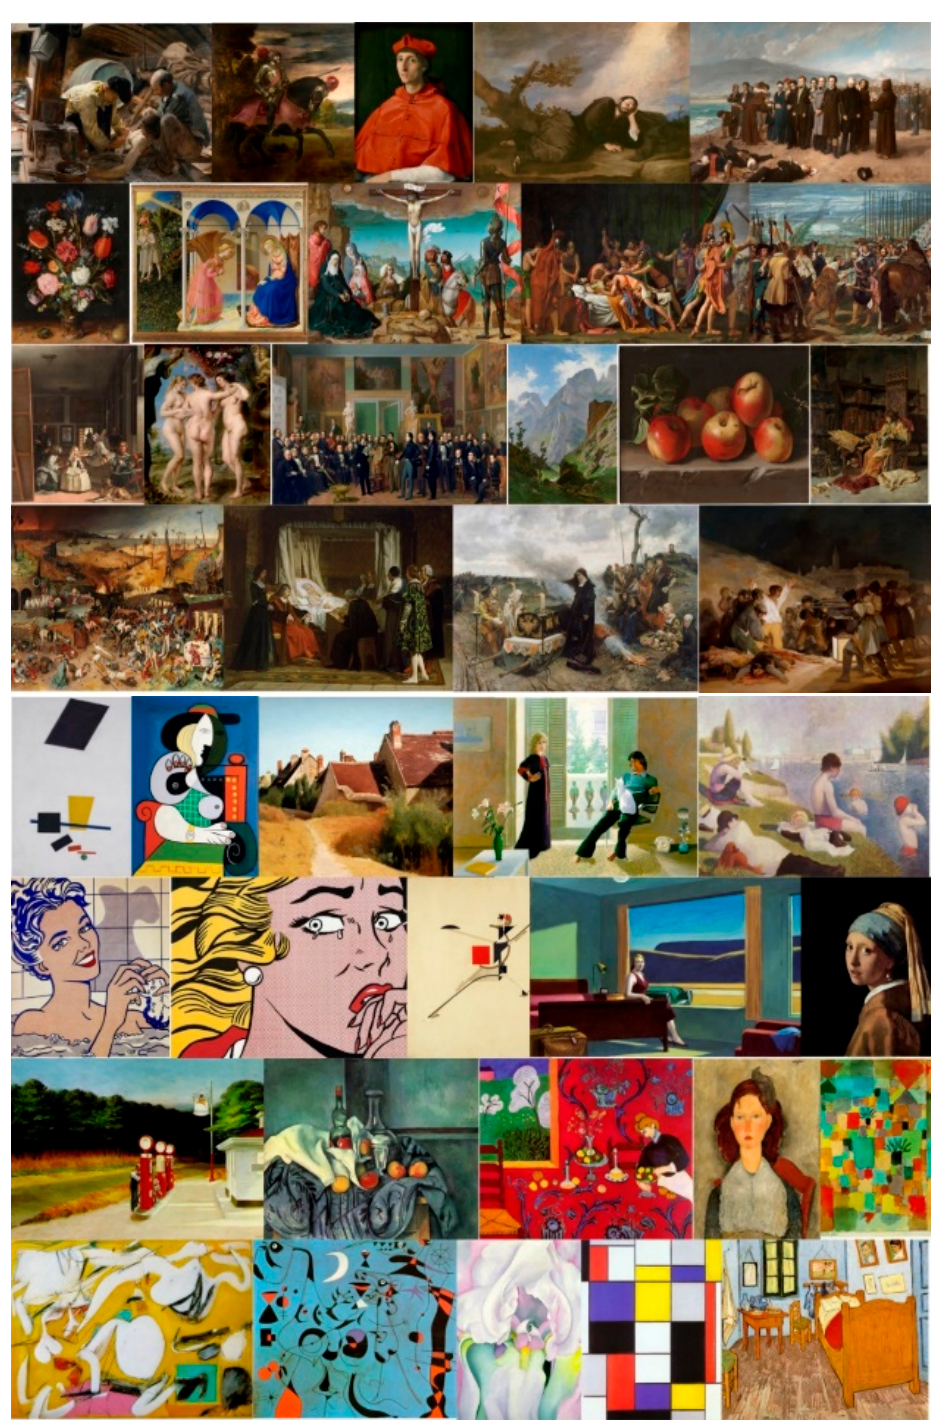
Figure 1. Paintings used in the experiment from (uppermost eight rows) the Prado museum [20] and from (lowermost eight rows) the Khan et al. dataset [22].